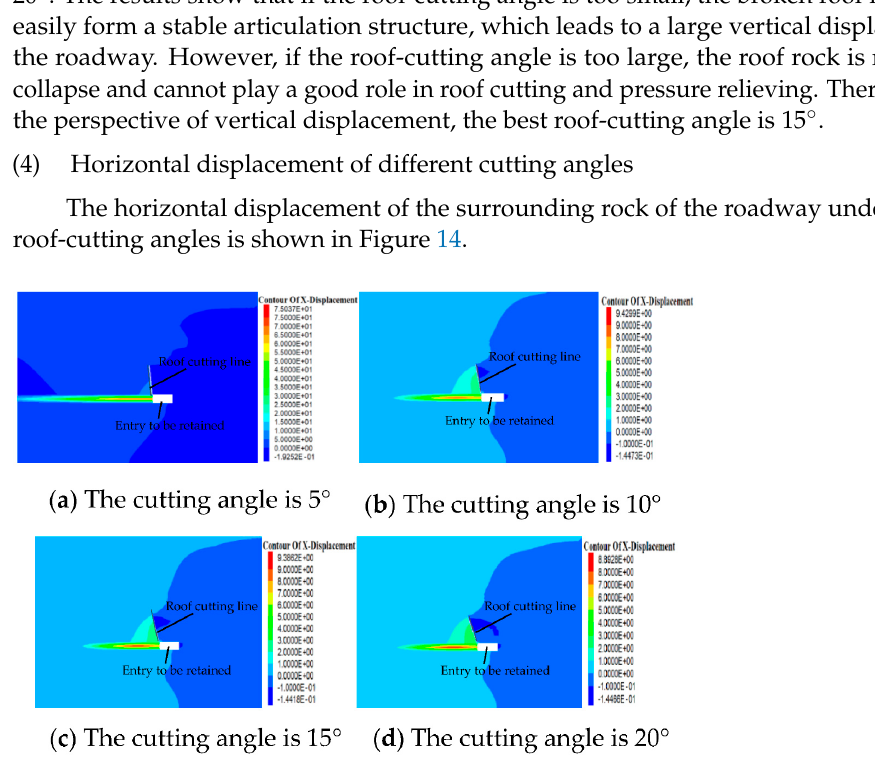
Figure 13. Vertical displacement of surrounding rock of the roadway under different cutting an- gles.